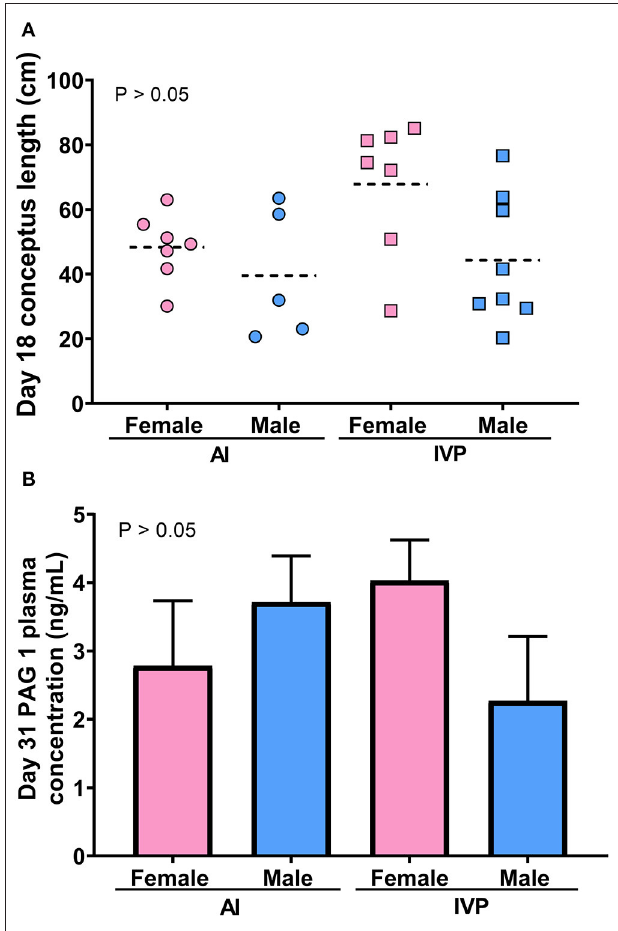
FIGURE 2 | Physical and endocrine comparison of female and male pregnancies at day 18 and 32 of development. (A) Distribution of the length of conceptuses on day 18 from AI or IVP. (B) Circulating concentrations of pregnancy associated glycoprotein 1 (PAG1) on day 31 of pregnancy, comparing sex and technique. Data are least square means ± SEM. Mean conceptus length is represented by the dashed